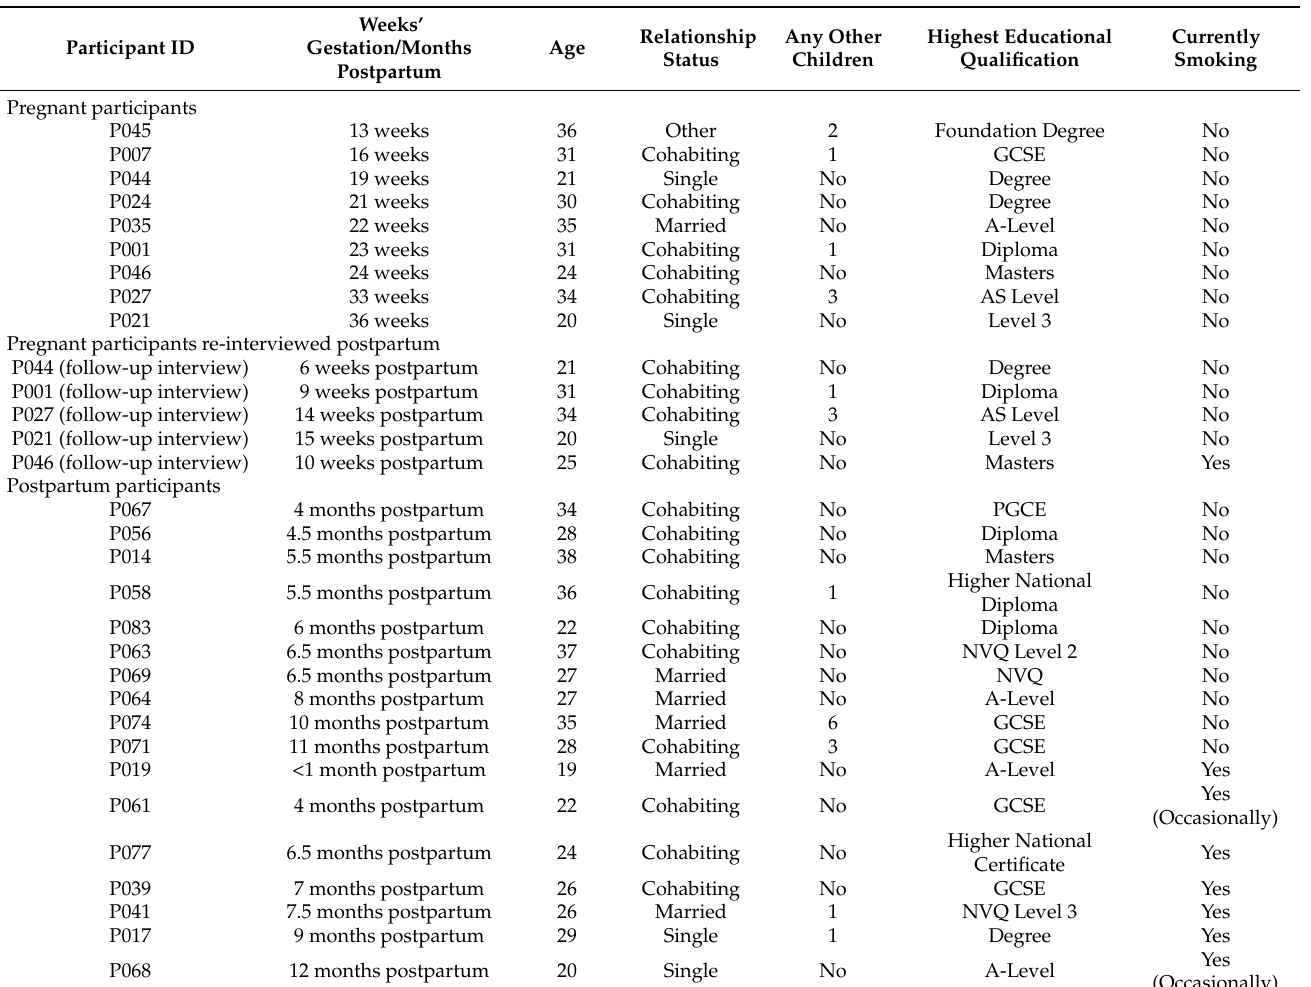
Table 1. Participant